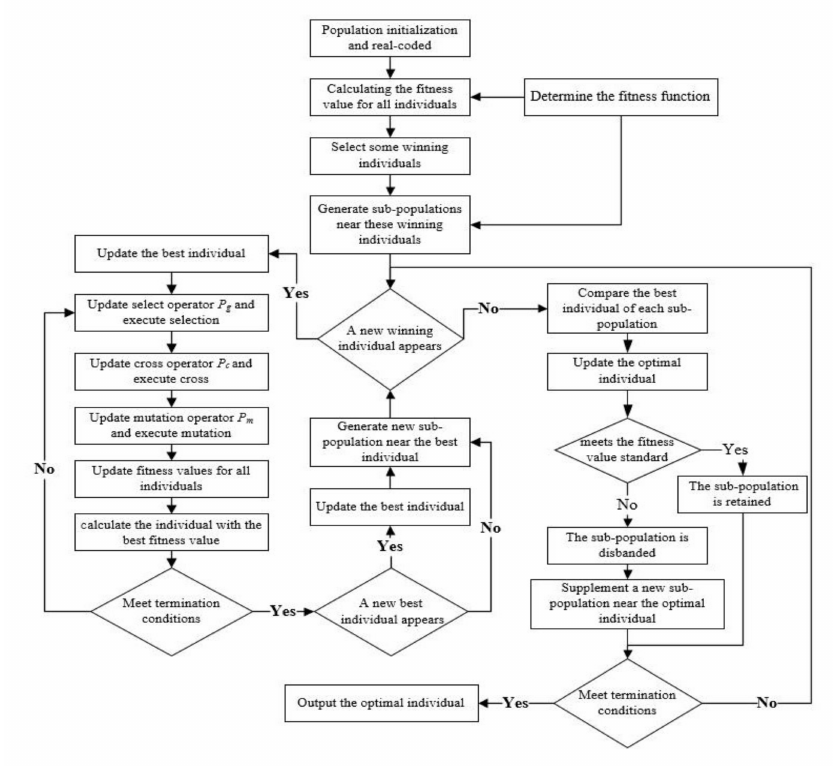
Figure 7. Flow chart of the Mind-evolved Advanced Genetic Algorithm